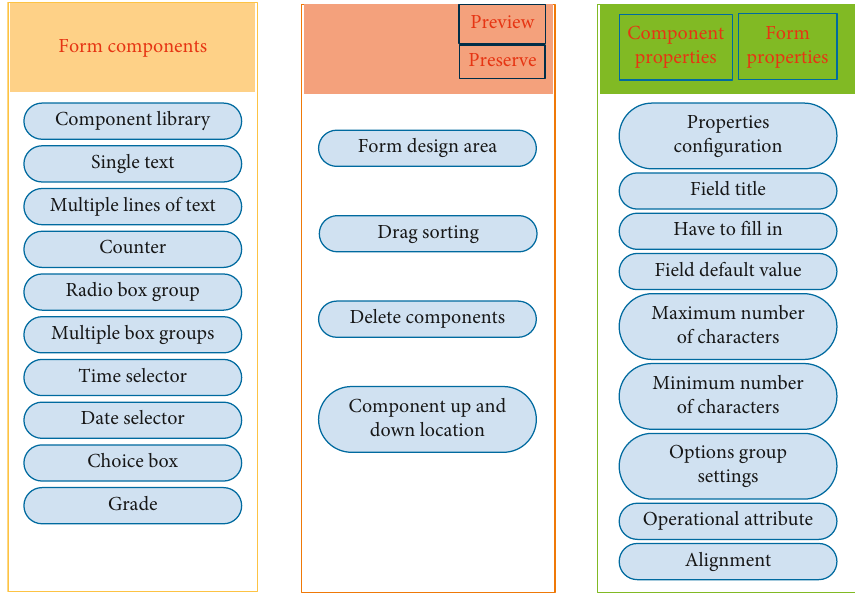
Figure 4: Simplified diagram of form interface